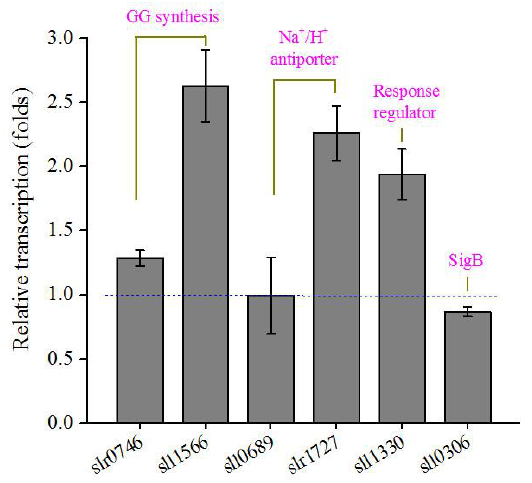
Figure 5. Relative transcriptional levels of six representative salt-responsive genes in transgenic Synechocystis upon salt stress as compared to the WT. Data are mean ± s.d. ( n = 3).